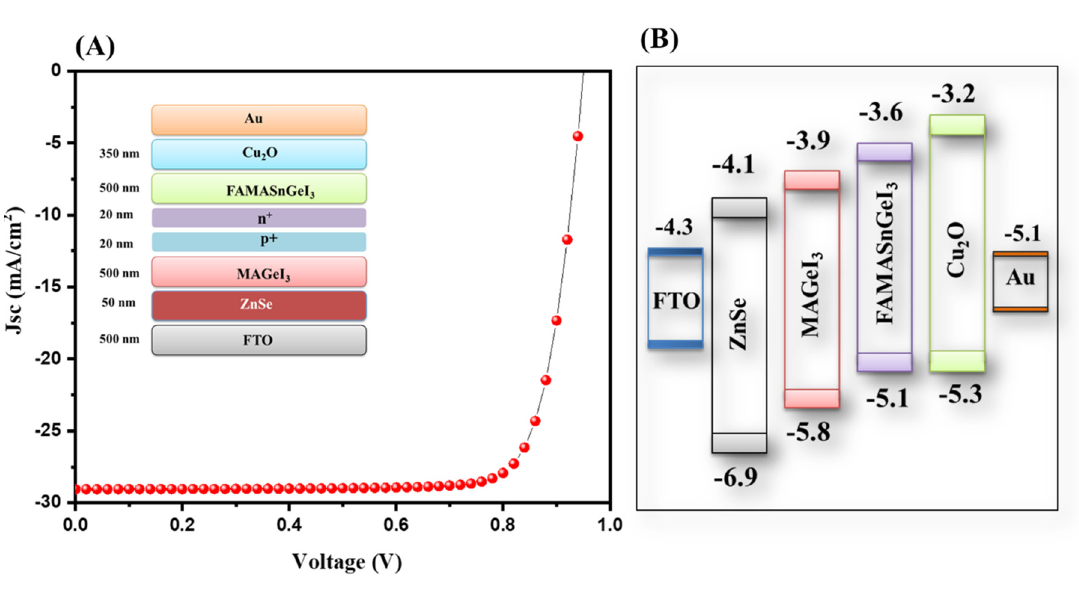
Figure 11. J–V curve ( A ) and energy level diagram ( B ) of tandem solar cells with ZnSe as the ETL. The observation revealed that the highest PCE of 22.40% was obtained for ZnSe as the ETL. The photovoltaic parameters of the ZnSe-ETL-based tandem solar cells are presented in Figure 11B. The energy level diagram of the simulated device is inserted in Figure